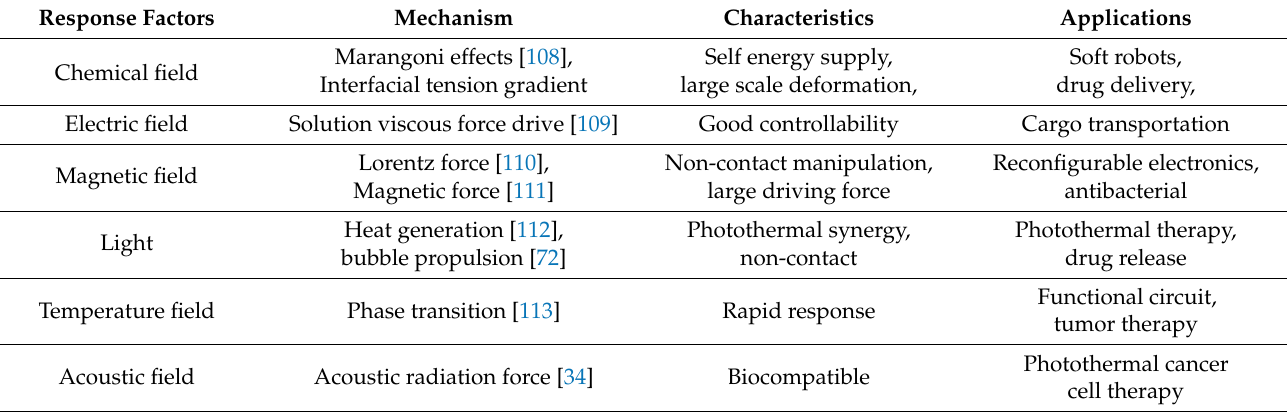
Table 2. The summary of the response characteristics of responsive liquid metal